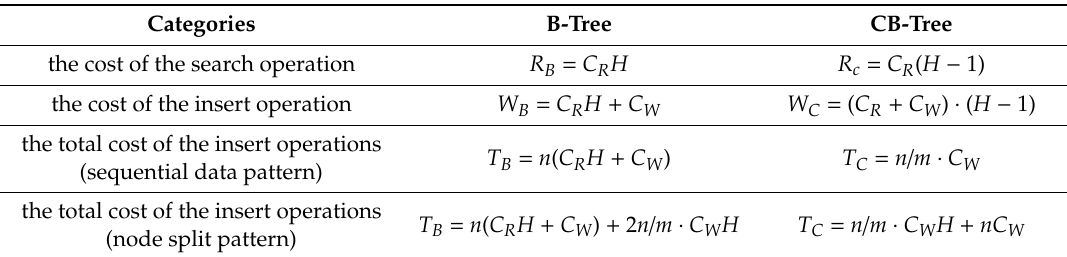
Table 3. Notation for evaluation of B-Tree and CB-Tree.